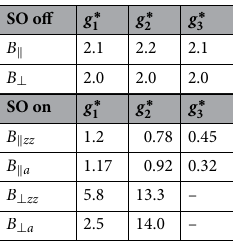
Figure 9. ( a , b ) Transconductance for the in-plane B edges. Double-spin states (of the same sign from both valleys) at E F that enhance the conductance are marked by white dashed lines along the peaks. ( c – f ) Band structure for the center of the constriction. Colorbar indicates expected value of the spin projected to the y axis. Left column ( a , c , e ) corresponds to calculations with NO SOI part of the Hamiltonian, while right column ( b , d , f ) are with SOI part,